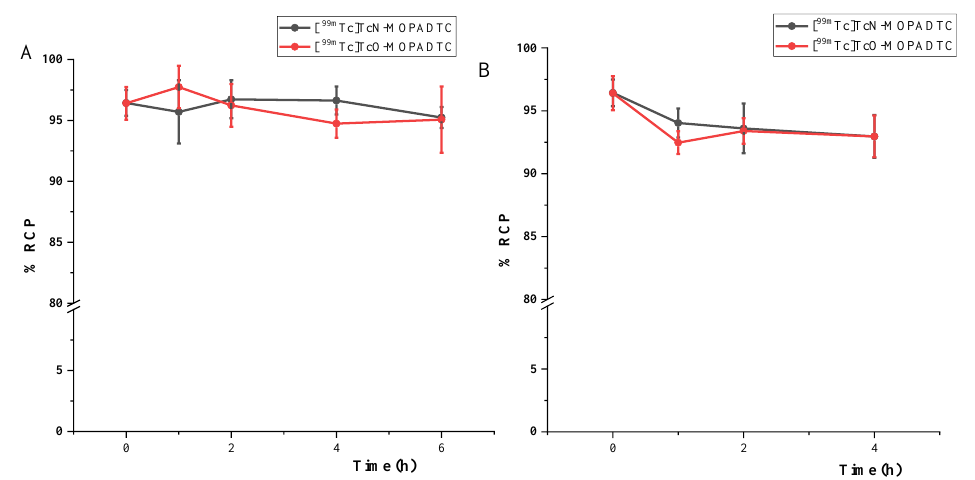
Figure 2. In vitro stability of [ 99m Tc]TcN-MOPADTC and [ 99m Tc]TcO-MOPADTC in saline ( A ) and mouse serum ( B ) ( n = 3).